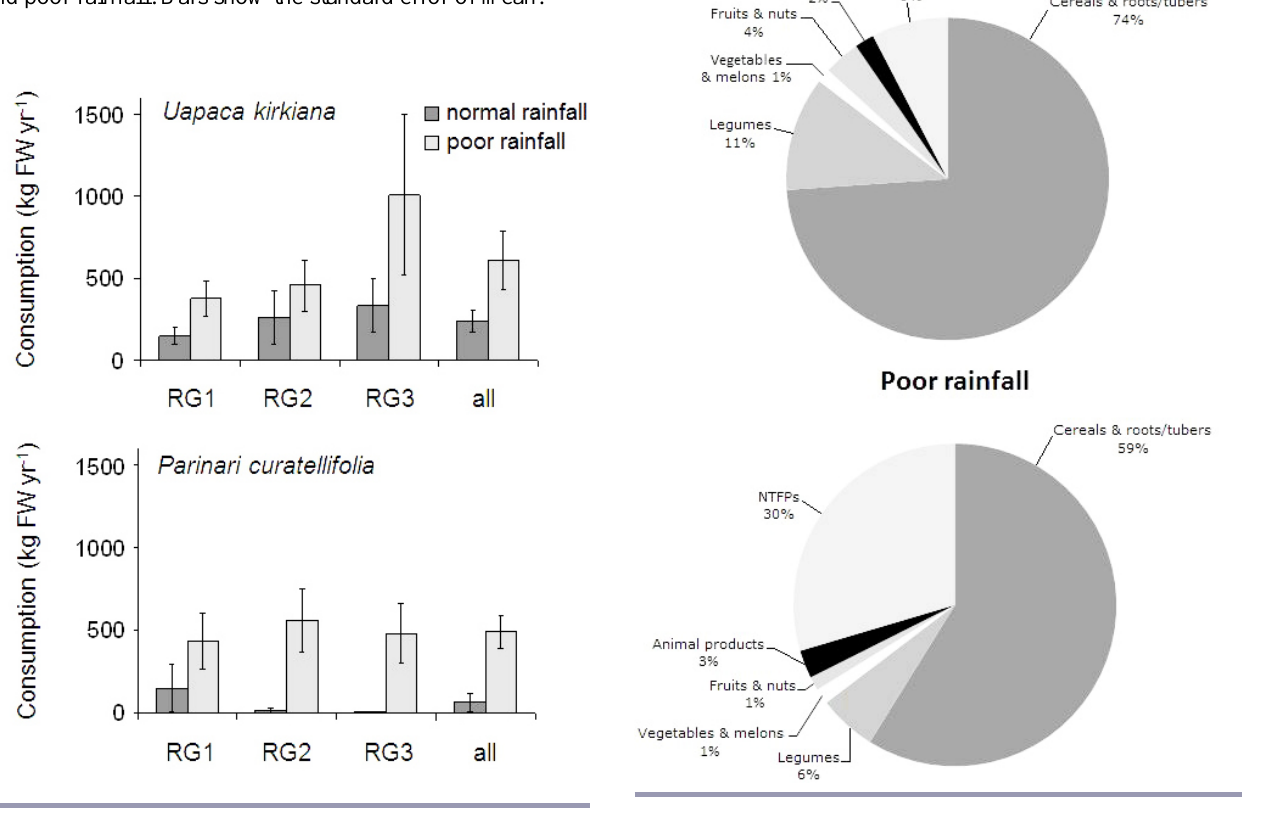
Fig. 6 . Consumption of Uapaca kirkiana and Parinari curatellifolia per resource group (RG) in times of normal and poor rainfall. Bars show the standard error of mean.